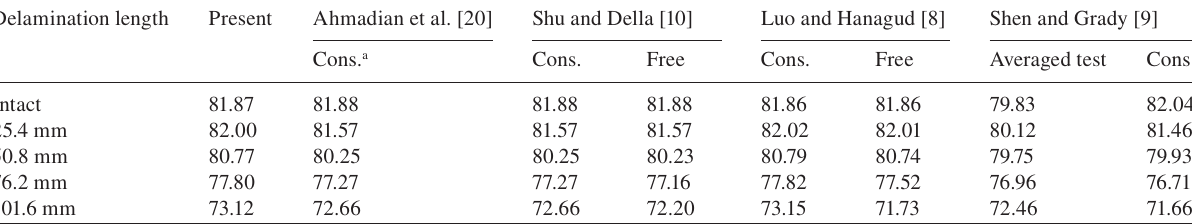
represent the delamination spanwise location and length,